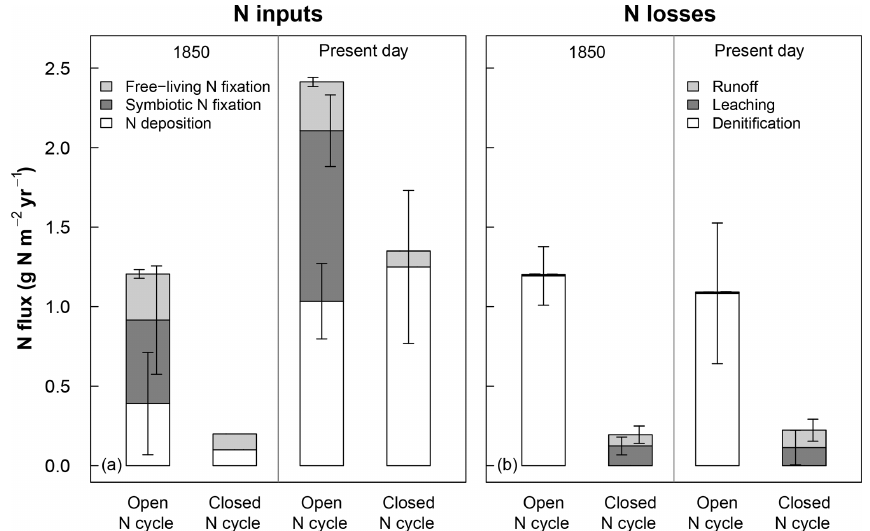
Figure 1. Rates of (a) nitrogen (N) inputs and (b) N losses averaged across sites for 1850 (using the last 20 years of the spin-up simulation) and the present day (using the last 20 years of the historical baseline simulation; see Sect. 2.3) for ecosystems with open and closed N cycles. Mean inputs and losses include sources that were > 0 . 1% of total fluxes. N deposition is based on input data files, while other fluxes are modeled in CLM5 (see Sect. 2.2). For ecosystems using a closed N cycle, N deposition, free-living N fixation, and N deposition were set to observation-based estimates. Denitrification was turned off because of the uncertainty around the portion of N losses due to this loss term (see Sect. 2.3.1). Error bars represent 1 standard deviation simulated across all